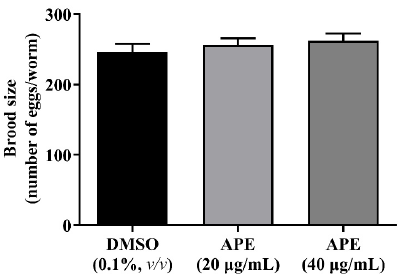
Figure 8. Effect of APE on C. elegans spawning. APE treatment did not affect the number of eggs laid by a worm versus the DMSO control group. Statistical significance was analyzed by one-way ANOVA ( p < 0.05).